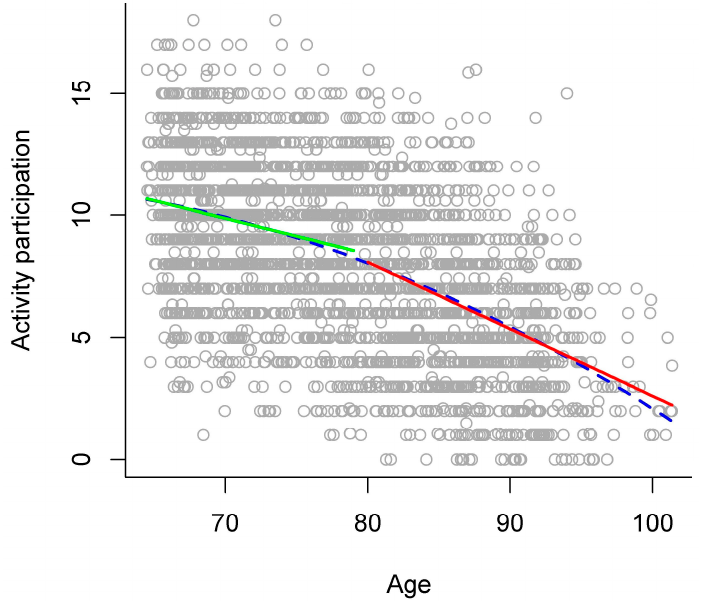
Figure 4. Age relations in activity participation. Number of activities plotted against chronological age, with different models of age relations: gradual model (blue dashed line) and stage model (young-old adults: green solid line versus old-old adults: red solid line).